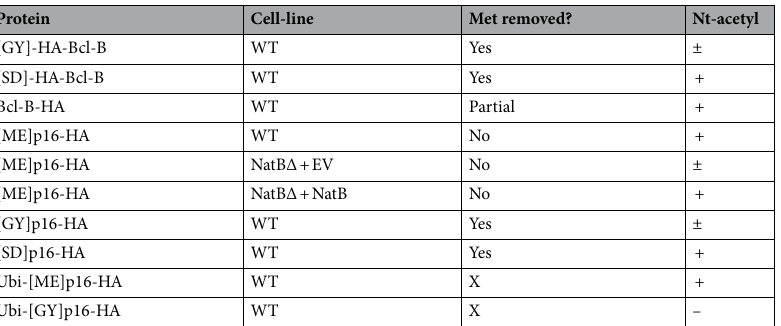
Table 1. MS-verified Nt-acetylation status of Bcl-B and p16 variants. Table summarizing the Nt-acetylation status of all Bcl-B and p16 variants that were analyzed by MS (also see Supplementary Figs. 1B,C; 2B; 3A–C and 5A,B). The “±” sign indicates that Nt-acetylated as well as Nt-acetyl-free tryptic peptides were detected. Also indicated is whether the initiator methionine was retained or removed. All experiments were done in HEK 293T cells, either wild-type (WT), or deficient for the NAA20 subunit of NatB (NatBΔ). The latter cell- line was reconstituted with an empty vector (+ EV) or NAA20 cDNA (+ NatB).